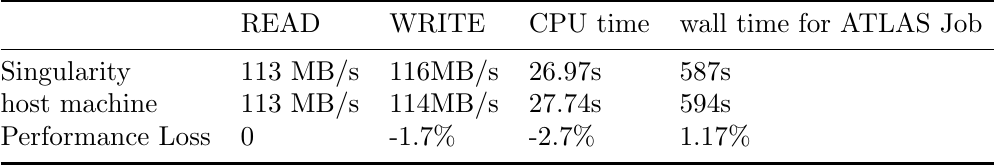
Table 1. Local performance test between host machine and